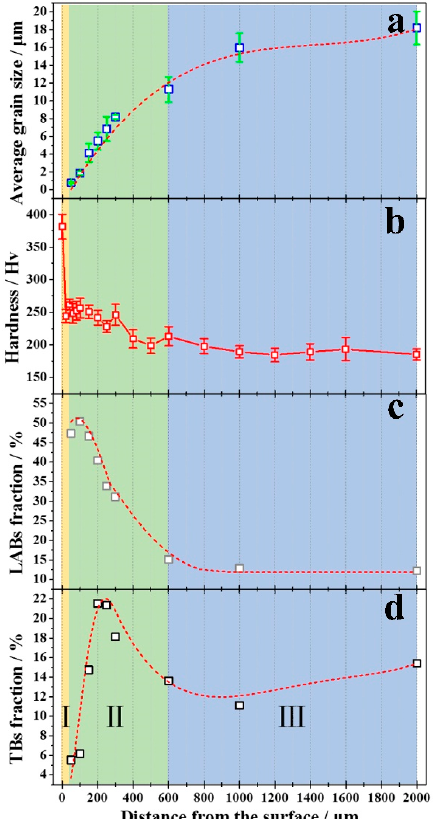
Figure 4. Distribution of ( a ) grain size; ( b ) hardness; ( c ) fractions of LABs and ( d ) fractions of twin boundaries (TBs) from the surface to the interior of the RASP-processed Ti.